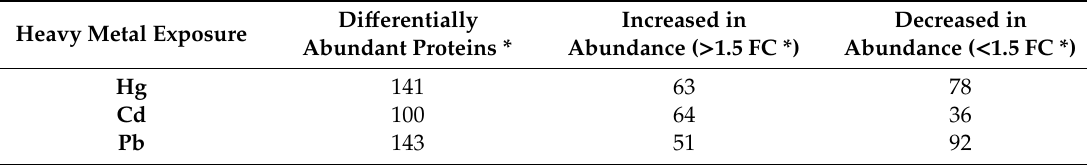
Table 1. Summary of proteins identified from E. gracilis Zm-strain. Triplicates were used for all experiments.